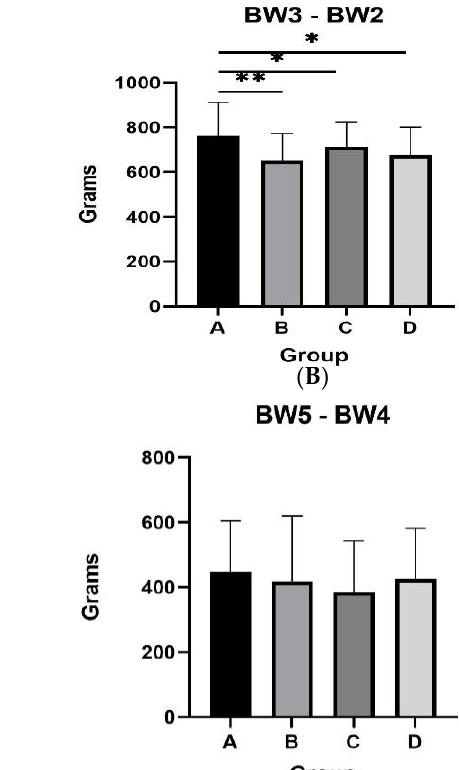
body weight was similar between groups ( p > 0.05). Body weights of male mink for the total experimental period are presented in Table 3.